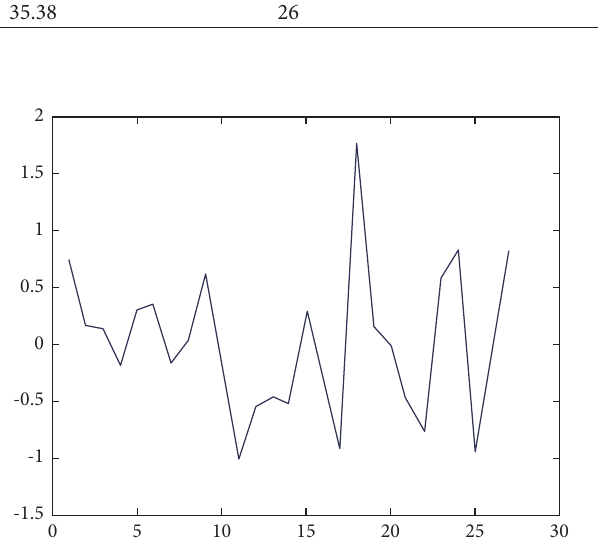
Figure 8: Errors vs. order of observations. Table 7: GDP and accessibility growth for road infrastructure